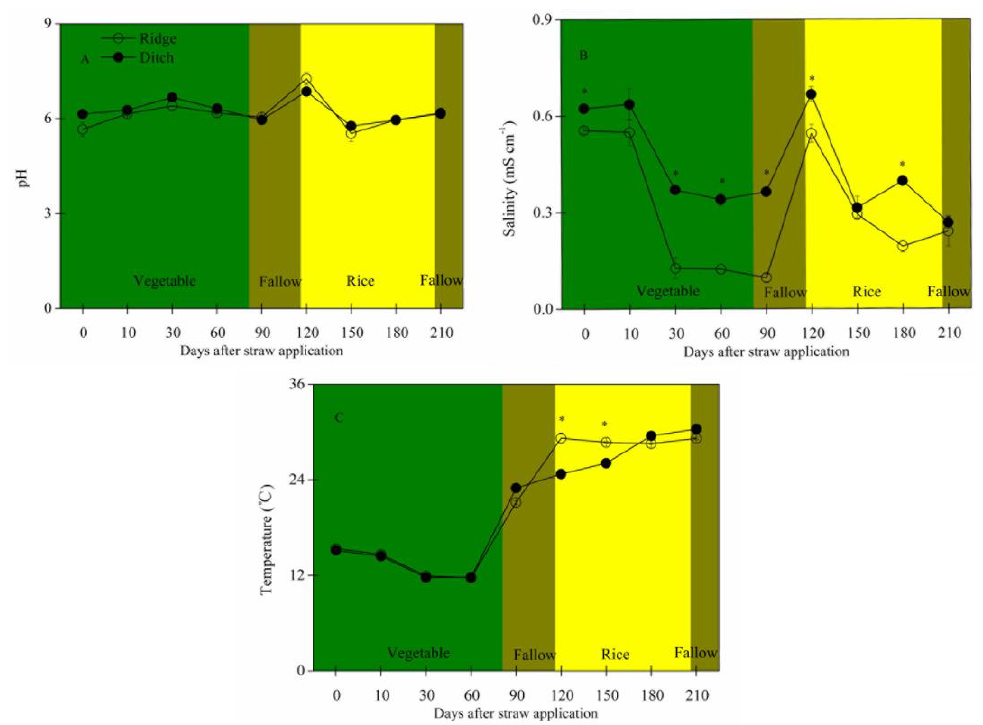
Figure A2. The dynamic changes of soil pH ( A ); temperature ( B ); and salinity ( C ) during rice straw decomposition. Statistically significant differences ( p < 0.5) between the ridges and ditches in each sampling date are highlighted with (*).